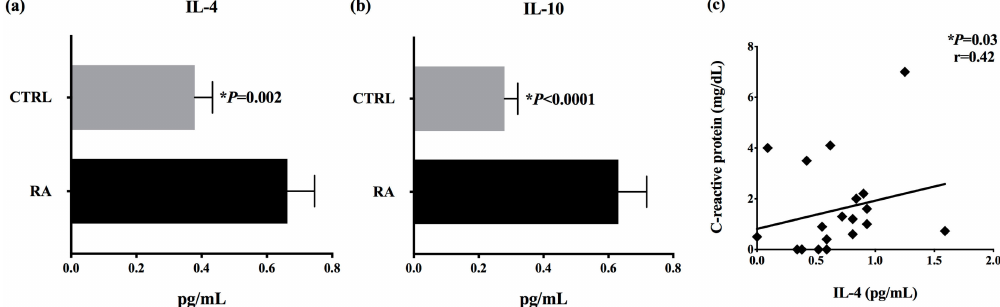
Figure 3. Cytokine concentrations (pg / mL) in patients (RA) and healthy controls (CTRL), and correlation with clinical data (Mann–Whitney U test). ( a ) IL-4 serum concentration, ( b ) IL-10 serum concentration, ( c ) positive Spearman’s correlation between IL-4 serum concentration and C-reactive protein levels (mg /